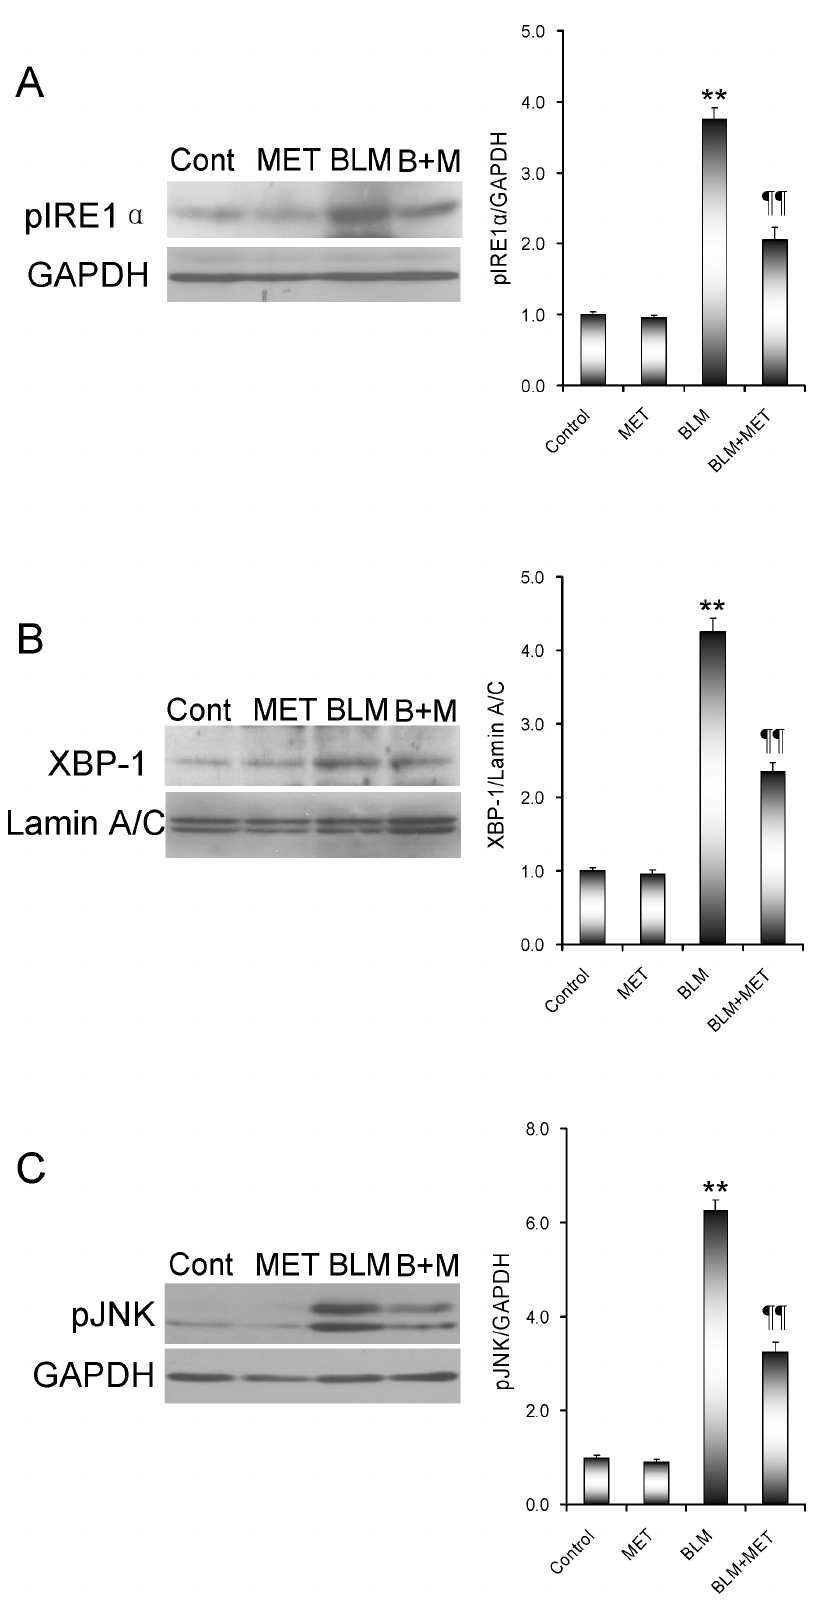
Figure 6. The effects of melatonin on BLM-induced activation of IRE1 path way in the lungs. All mice except controls were intratrac- + melatonin group,micewerei.p.injected withmelatonin (5 mg/kg) daily.Lungswerecollectedat21days a wasdetectedusingimmunoblots.(B)NuclearXBP-1wasdetectedusingimmunoblots.(C)PulmonarypJNKwasdetected after